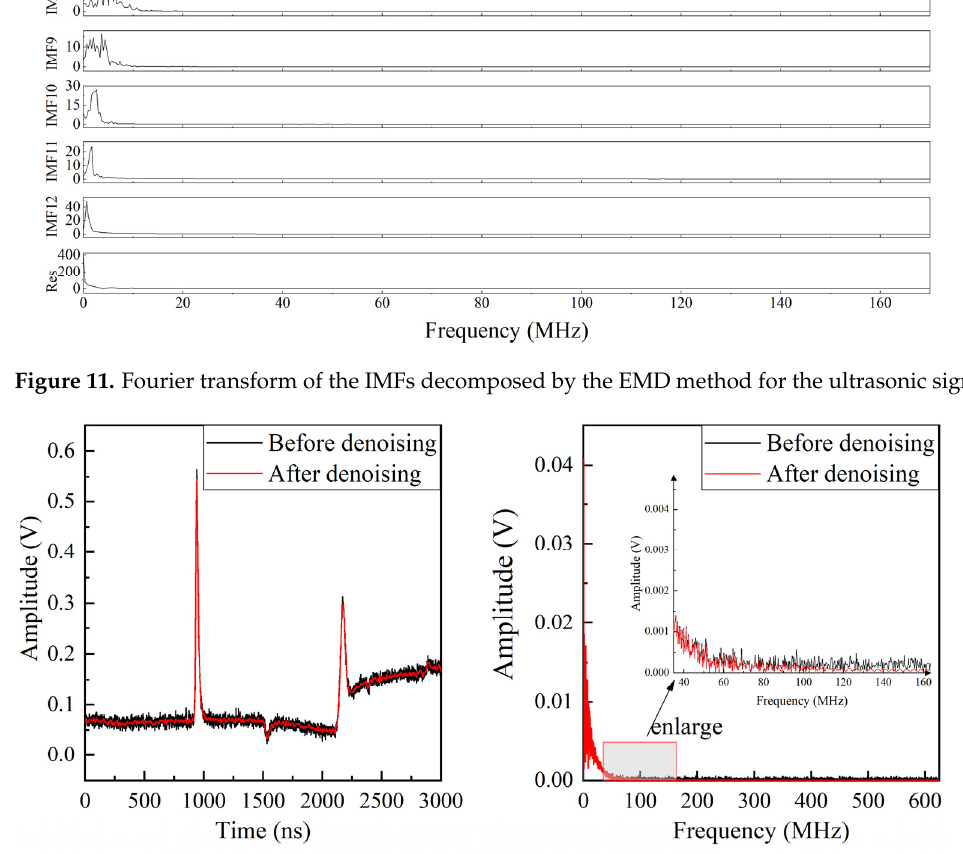
Sensors 2023 , 23 , x FOR PEER REVIEW 15 of 16